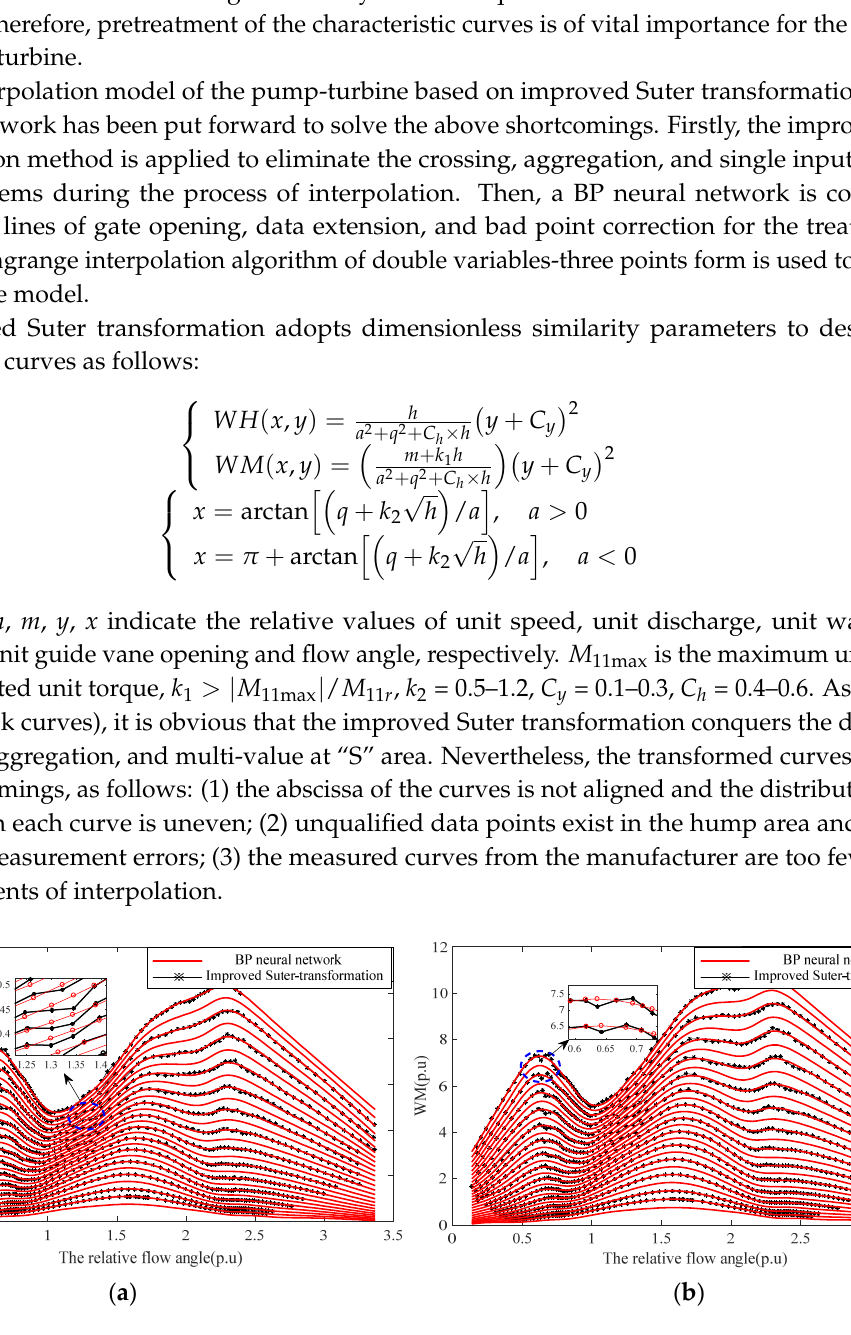
Figure 3. Topology diagram of the full pipeline system: ( a ) Single tube-single unit; ( b ) single tube-double units.